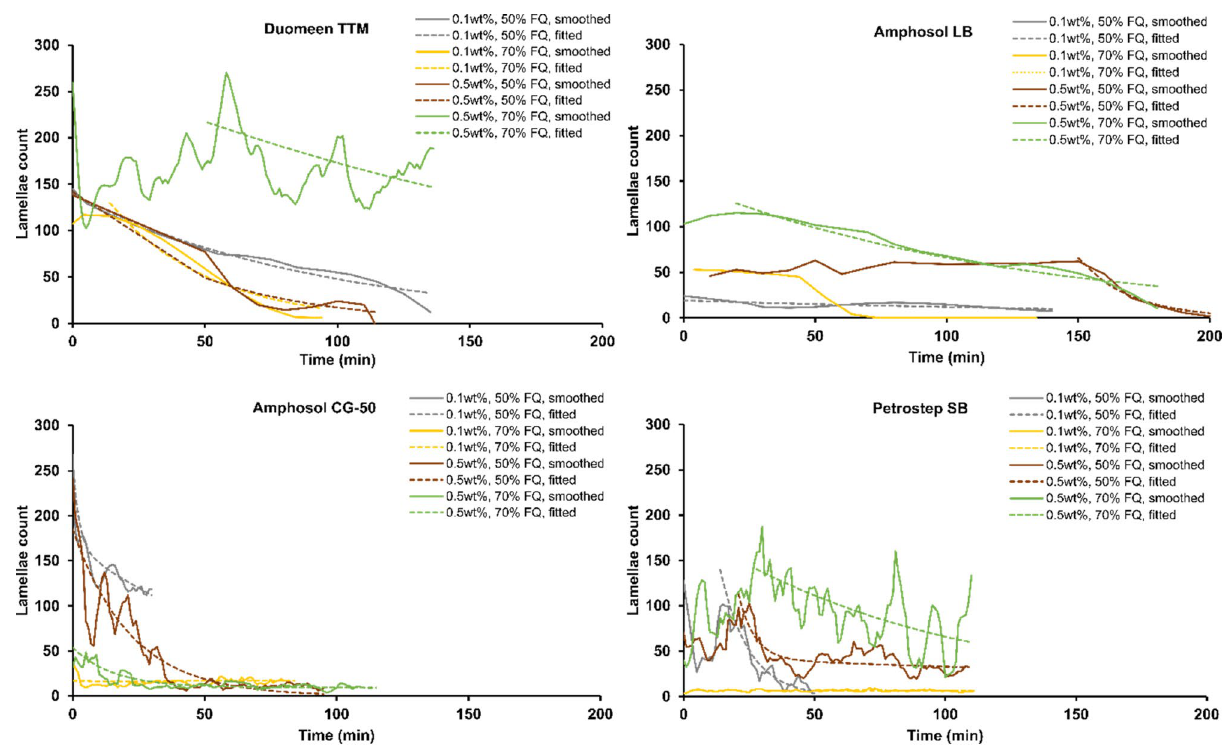
Figure 10. Decay of Savitzky–Golay filtered lamellae counts in the porous media of microfluidic chips during experiments of sealed-off two-phase flow of Sc-CO 2 with 0.1 wt% and 0.5 wt% surfactants in Brine 1, at qualities 50% and 70%. Exponential fits for half-life calculations are described in the